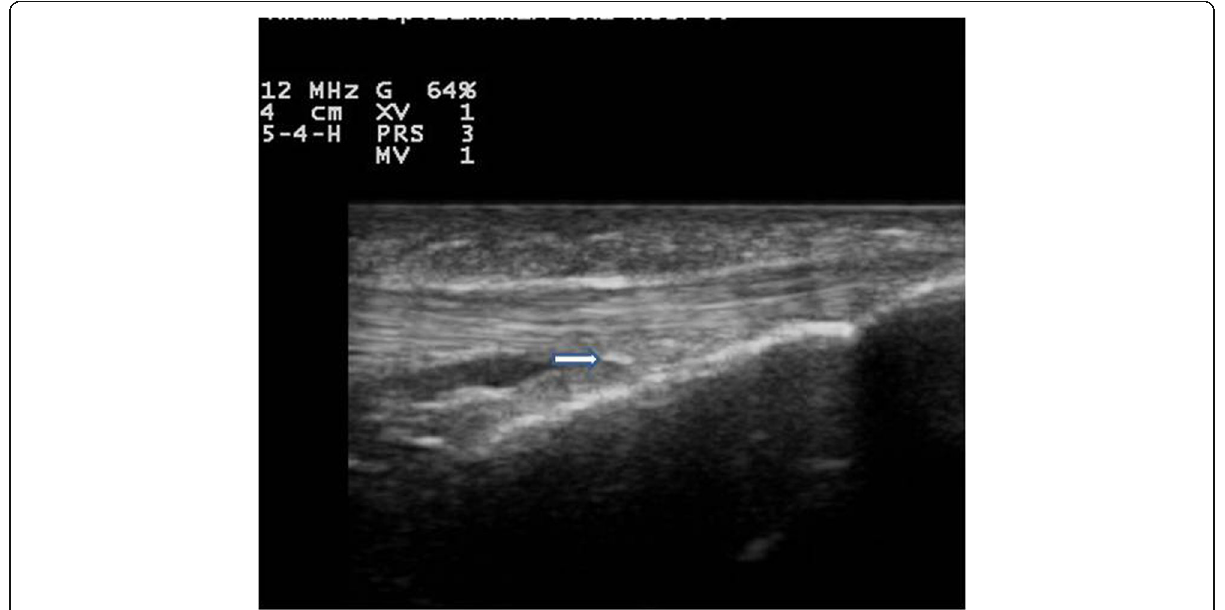
Fig. 10 MSUS of right triceps tendon of 35 years female RA patient showing abnormal structure and calcification (white